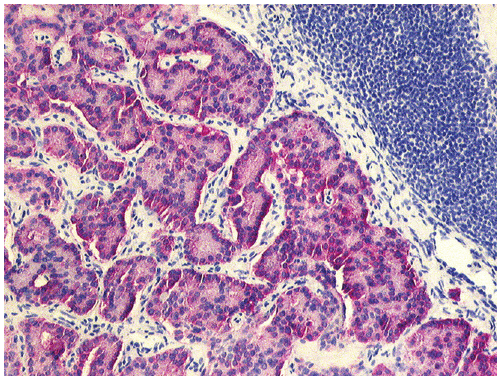
Figure 1: Trabecular epithelial cell proliferation with positive expression of synatophysin